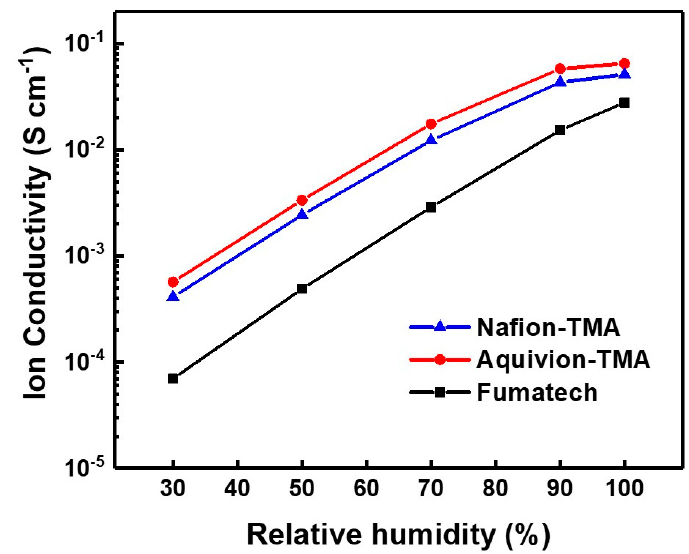
Figure 3. In addition, the ion conductivities of the perfluorinated ionomers were less dependent